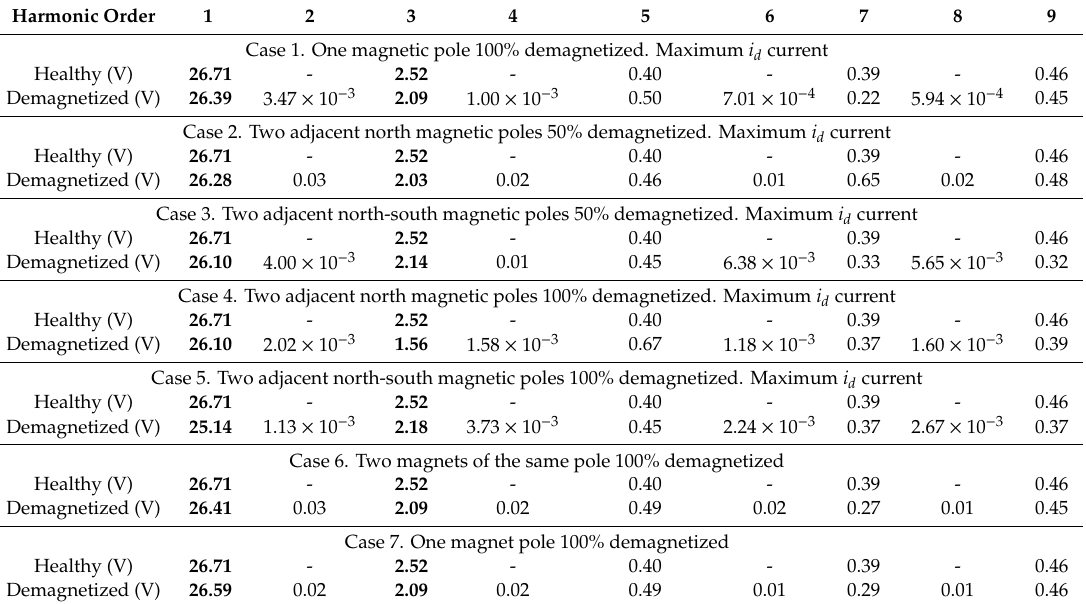
Table 4. Harmonic content of the ZSVC underrated speed and applying the maximum i d current ( i q = 0). Healthy and partially demagnetized fPMa-SynRMs. Harmonic